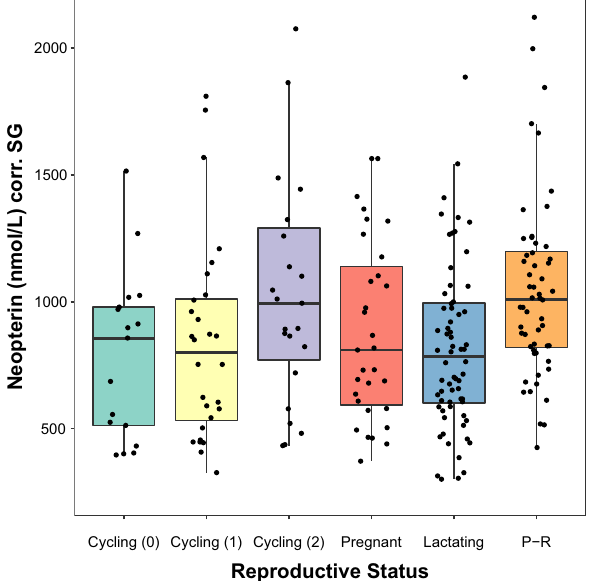
Figure 2. Urinary neopterin levels of female chimpanzees as predicted by reproductive status. Reproductive statuses include cycling without a sexual swelling (“Cycling 0”), cycling with a partial sexual swelling (“Cycling 1”), cycling with a full sexual swelling (“Cycling 2”), pregnant, lactating, and post-reproductive (“P-R”). Upper and lower bounds of the boxes demarcate the 75th and 25th percentiles, respectively, and bold horizontal lines represent